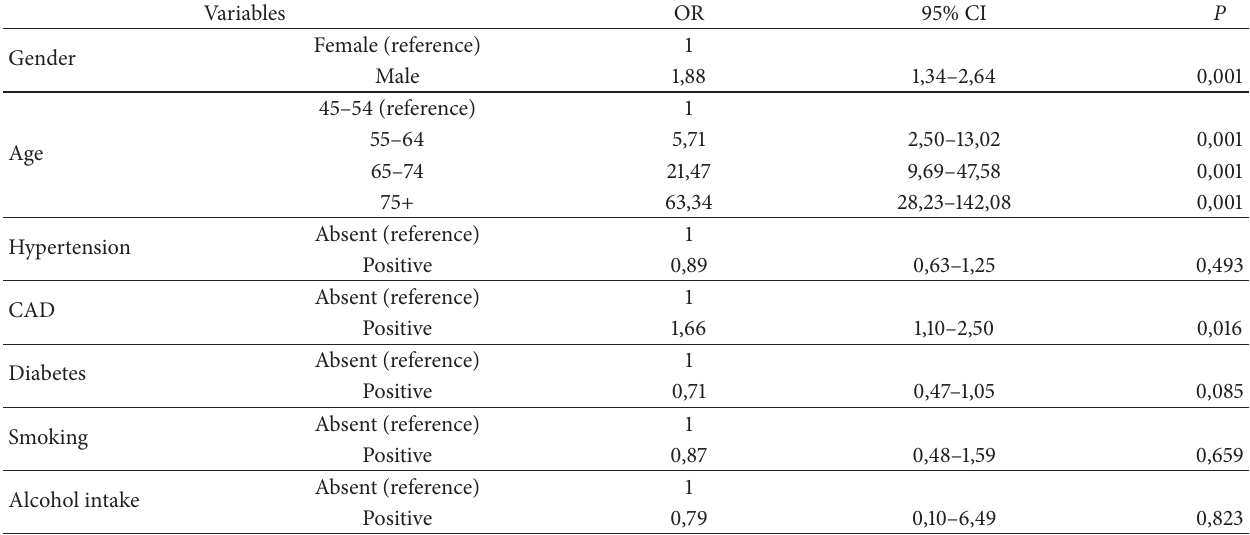
Table 5: Associations for XFS using logistic regression